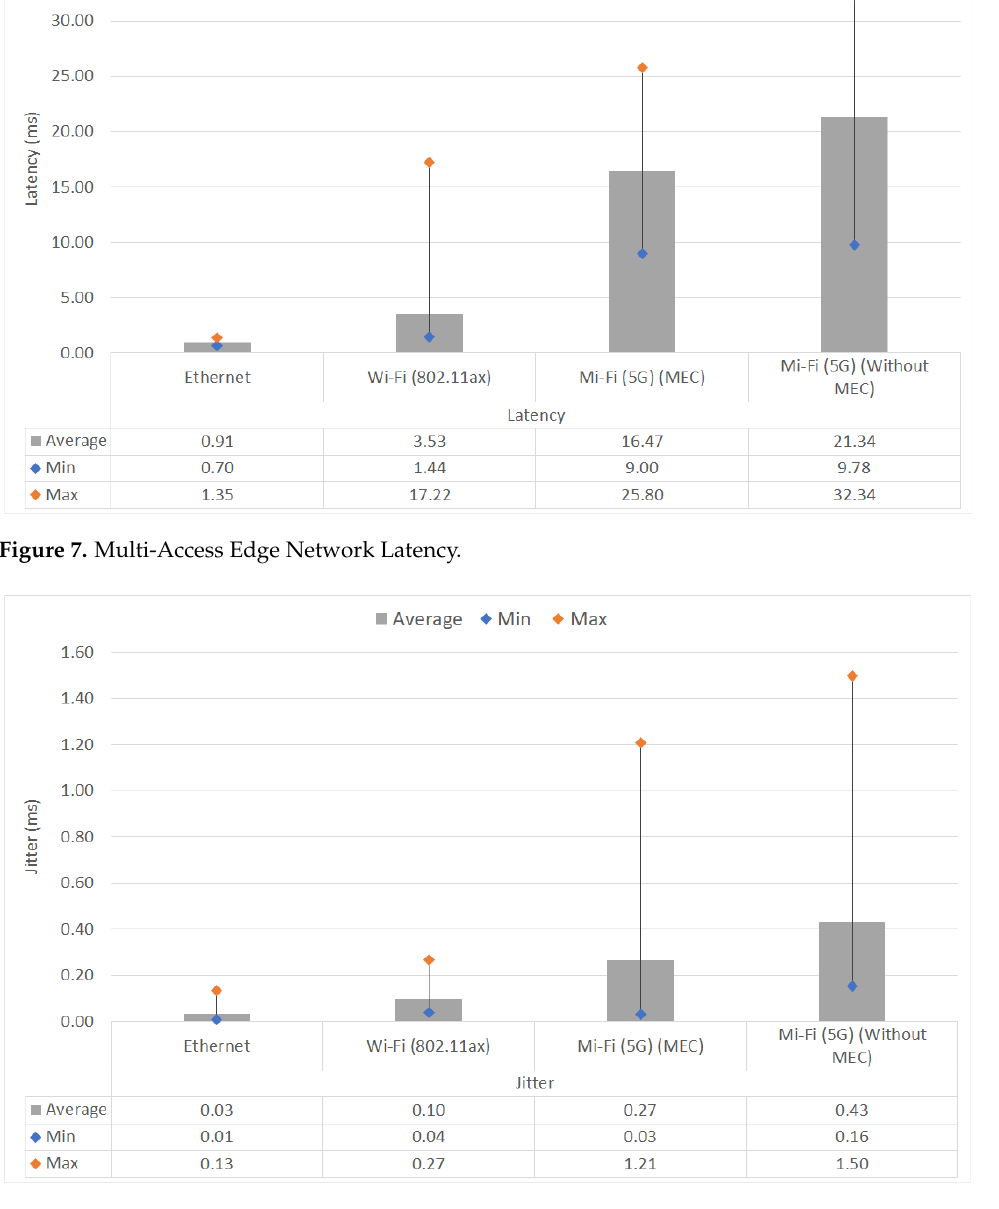
Figure 8. Multi-Access Edge Network Jitter.